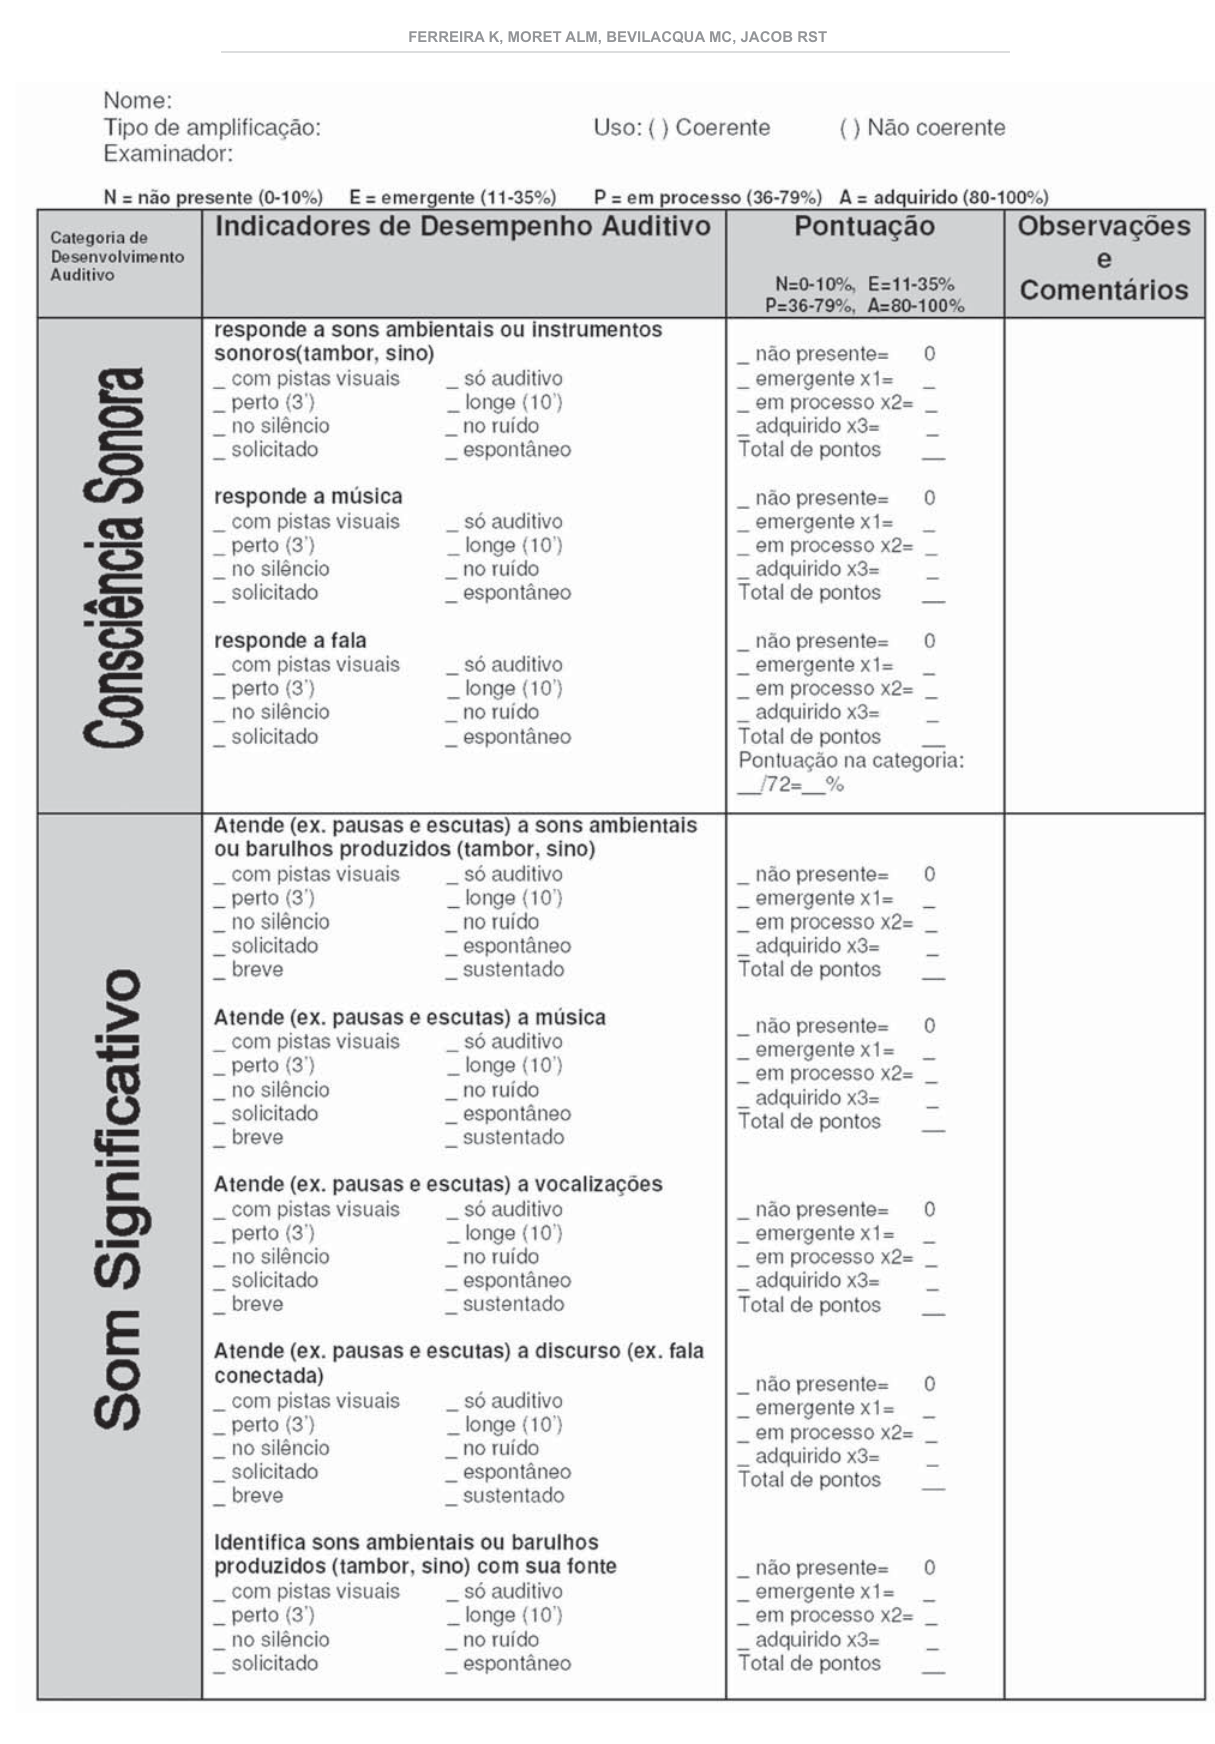
Figures 1A- Final FAPI translation into Portuguese (original in English: Stredler-Brown & Johnson 25